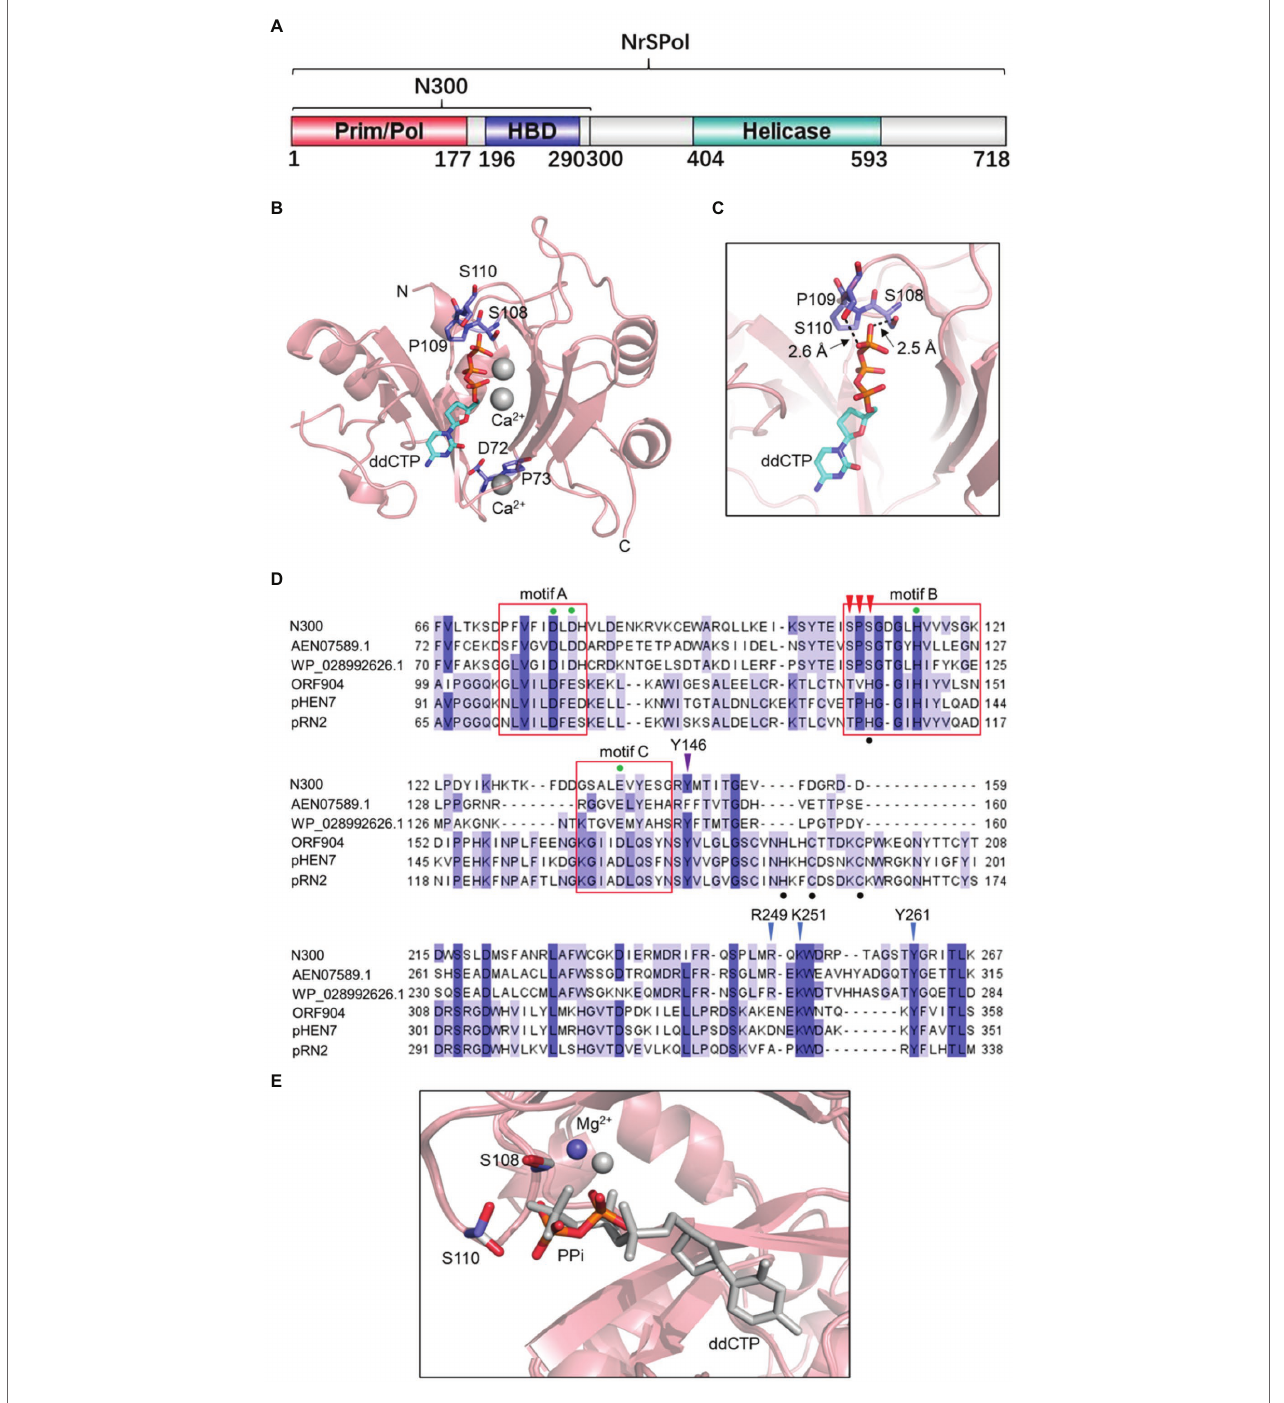
FIGURE 1 | A serine-rich (SPS) loop in the N300 structure. (A) The domain architecture of NrS-1 phage polymerase (NrSPol). (B) Ribbon diagram of N300. The Prim/Pol domain adopts a saddle-shaped fold. The ddCTP and two Ca 2+ ions are located at the central cleft and are coordinated by a serine-rich (SPS) loop. A chelated metal ion is found at the bottom of N300 structure and is assigned to Ca 2+ due to the high Ca 2+ concentration in the crystal conditions. (C) Detailed interactions between S108, S110, and the γ -phosphate of ddCTP. (D) Sequence alignment of the catalytic domain of N300 and other PrimPol proteins. The red boxes indicate the motif A, B, and C. The green dots indicate the key residues in the motif A, B, and C. The black dots indicate the zinc finger motif present in ORF904 and its orthologs. The red arrowheads indicate the SPS motif in N300 and its orthologs. The purple arrowhead indicates the position of Y146 of N300. The blue arrowheads indicate the positions of key residues R249, K251, Y261 in the HBD domain of N300. More details for the alignment of archaeo-eukaryotic primase (AEP) family proteins including BcMCM and TthPrimPol can be seen elsewhere (Picher et al., 2016). (E) Overlay of PPi/Mg 2+ -bound N300 structure (colored) and ddCTP/Ca 2+ -bound N300 structure